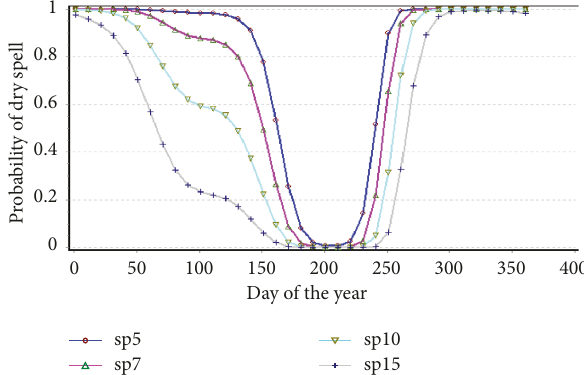
Figure 2: Dry spell lengths of 5, 7, 10, and 15 days at Welmera district (1988–2017).